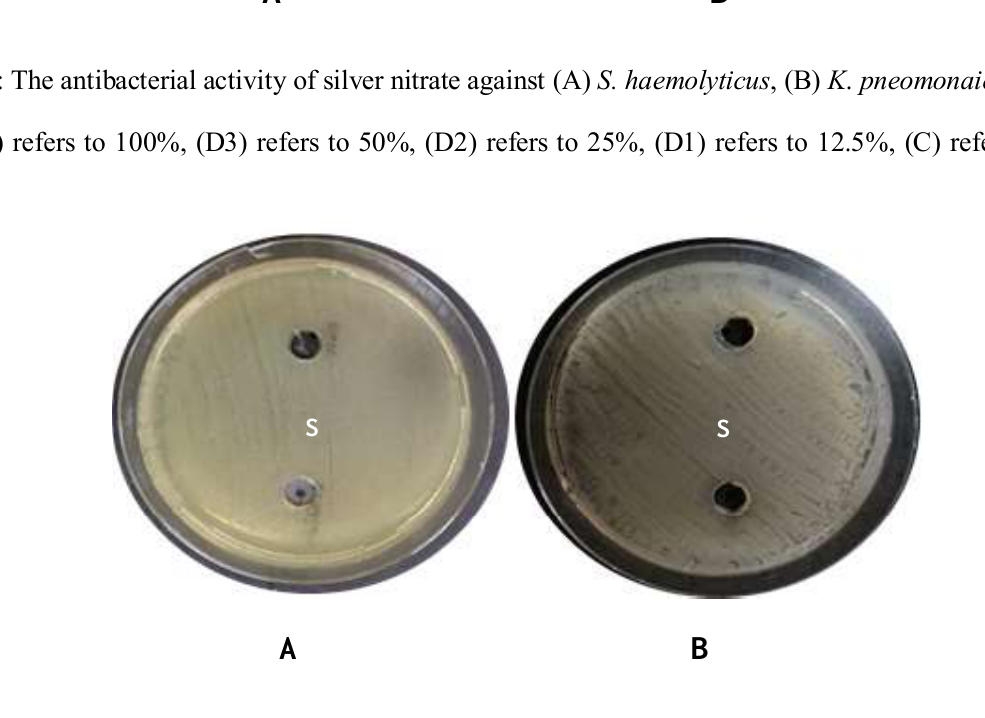
Figure 5: The antibacterial activity of C. albicans supernatant against (A) S. haemolyticus , (B) K. pneomonaie